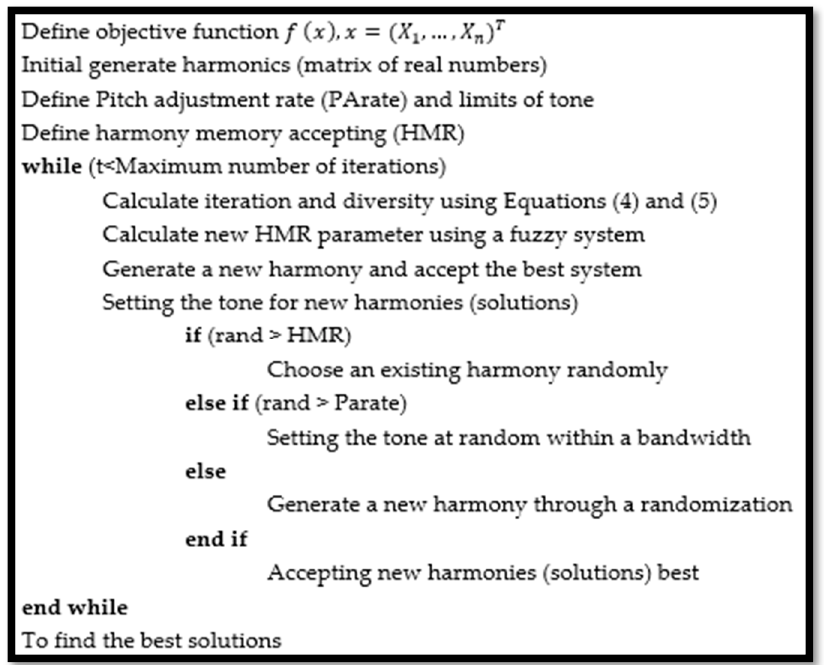
Figure 16. Fuzzy harmony search algorithm.